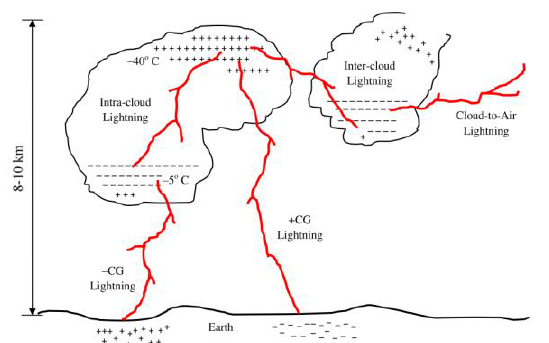
Fig. 1. Depiction of various forms of tropospheric lightning discharges.